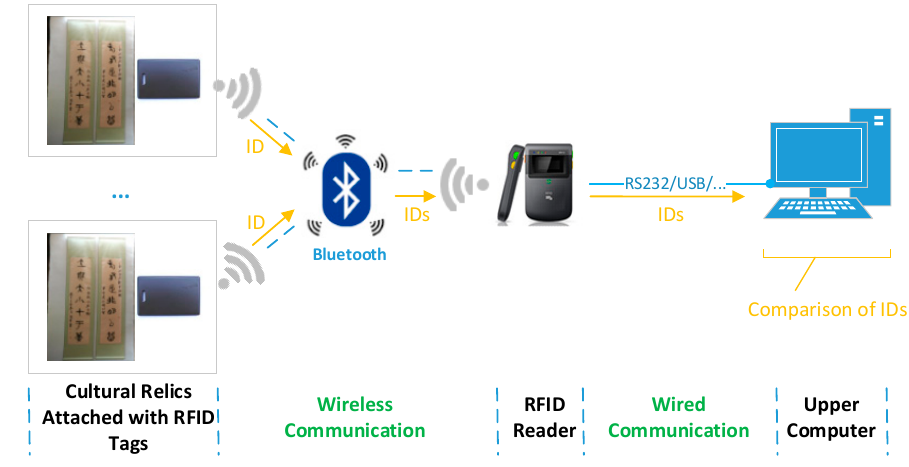
Figure 9. RFID-based loss prevention for cultural relics.